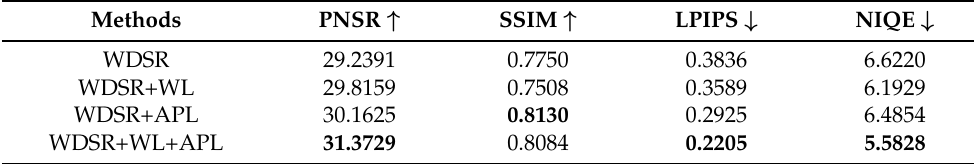
Table 3. Ablation study on the proposed super-resolution network. The best values are in